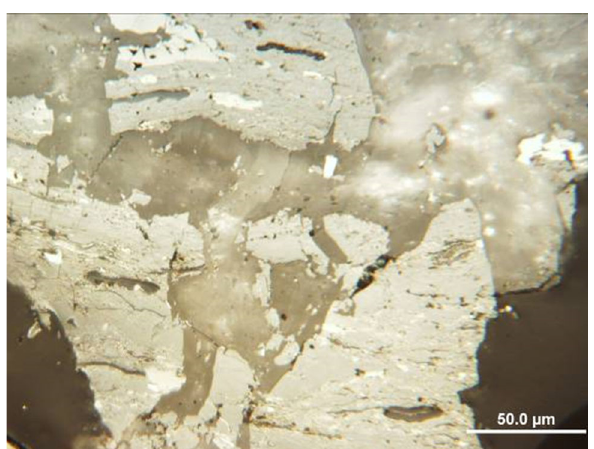
Fig. 13 Vitrinite with dispersed macerals of liptinite and inertinite faulted by calcite